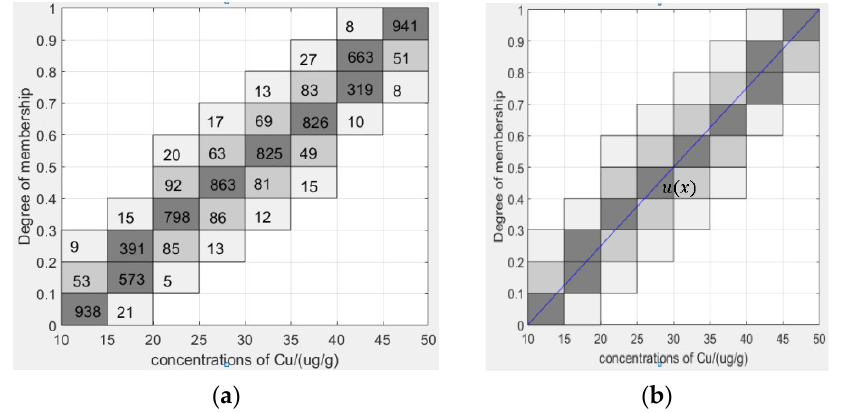
Figure 2. ( a ) Number of evaluators in interval data; ( b ) Type-1 membership function.